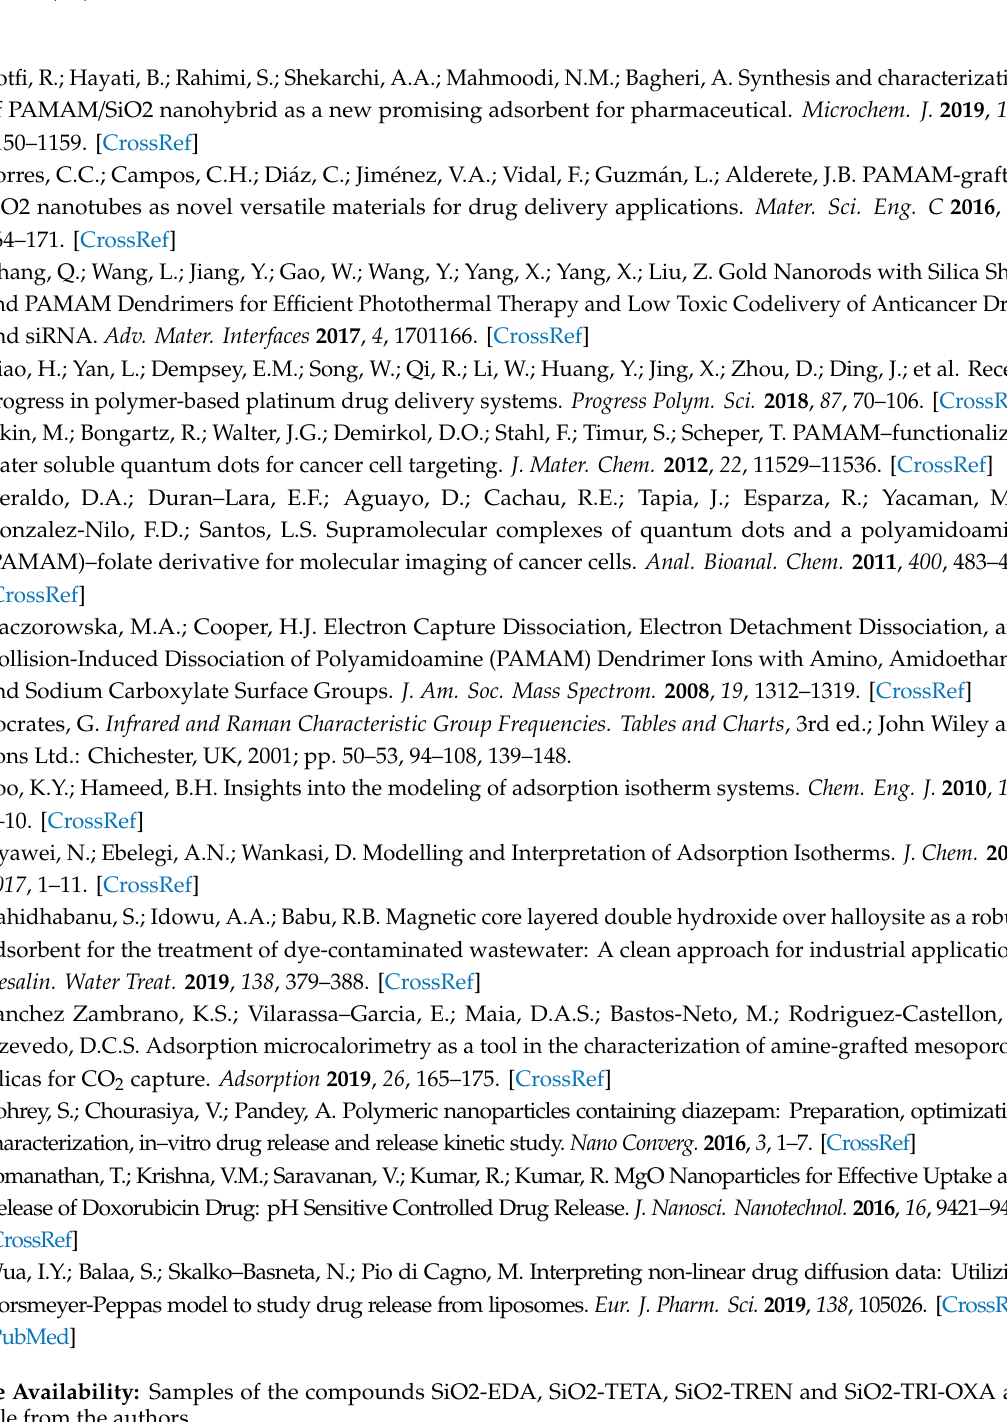
Sample Availability: Samples of the compounds SiO2-EDA, SiO2-TETA, SiO2-TREN and SiO2-TRI-OXA are available from the